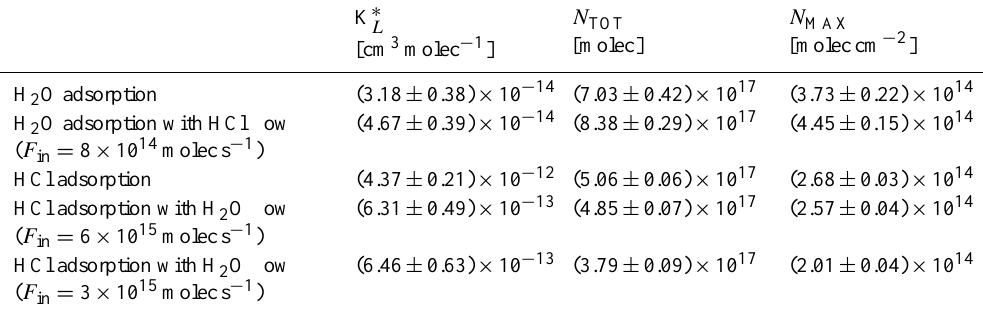
O Phase Diagram. 1234 2